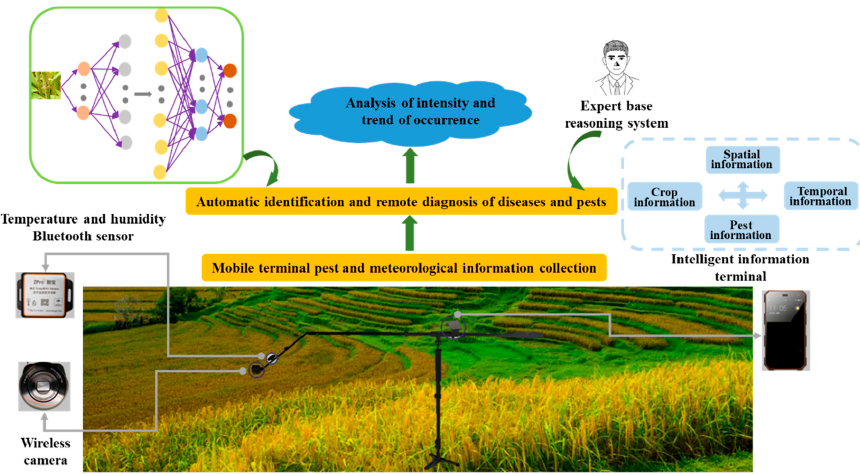
Figure 1. Overview of intelligent plant protection monitoring system.